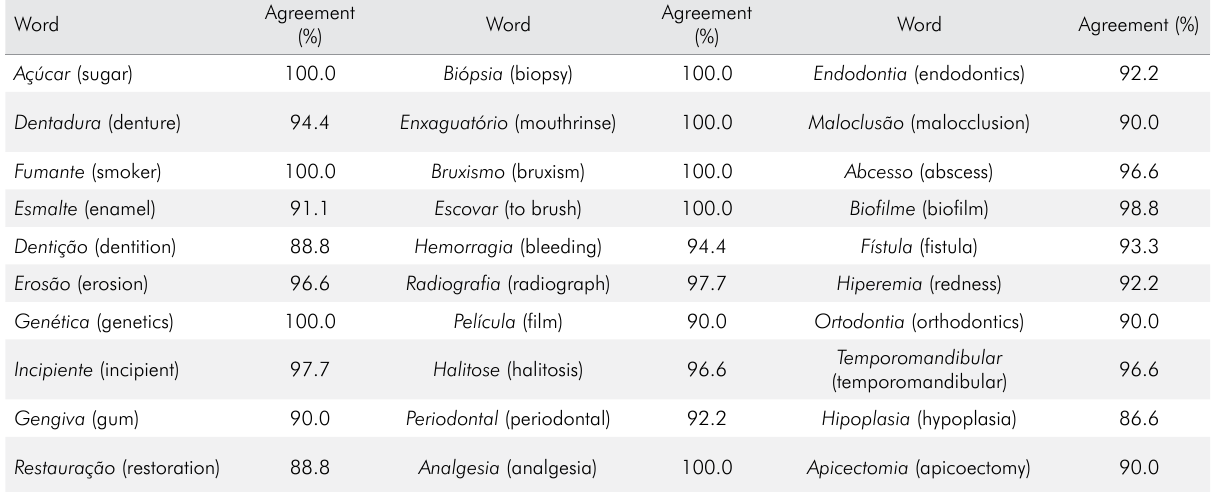
Table 2. Percentage of agreement for each word of the BREALD-30 considering the total number of interviewers in relation to the gold standard